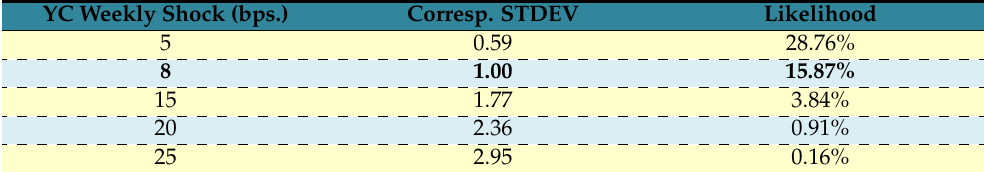
Table 6. Likelihood of principal components’ weekly yield curve shocks on 28 February 2020. YC Weekly Shock (bps.) Corresp.